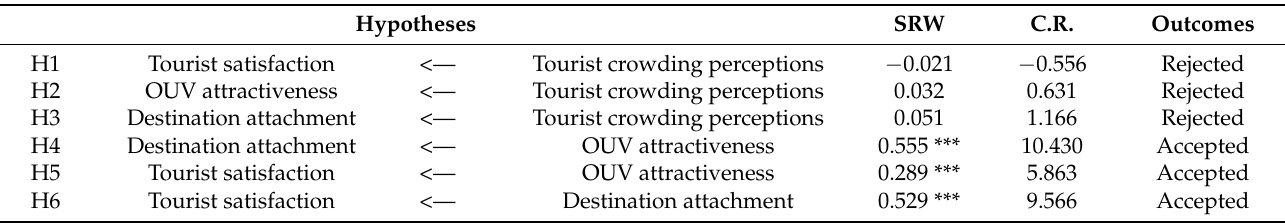
Figure 3. Results of the structural model analysis. Note: *** Significance at 0.001 level. Table 6. Overview of hypotheses analysis results.